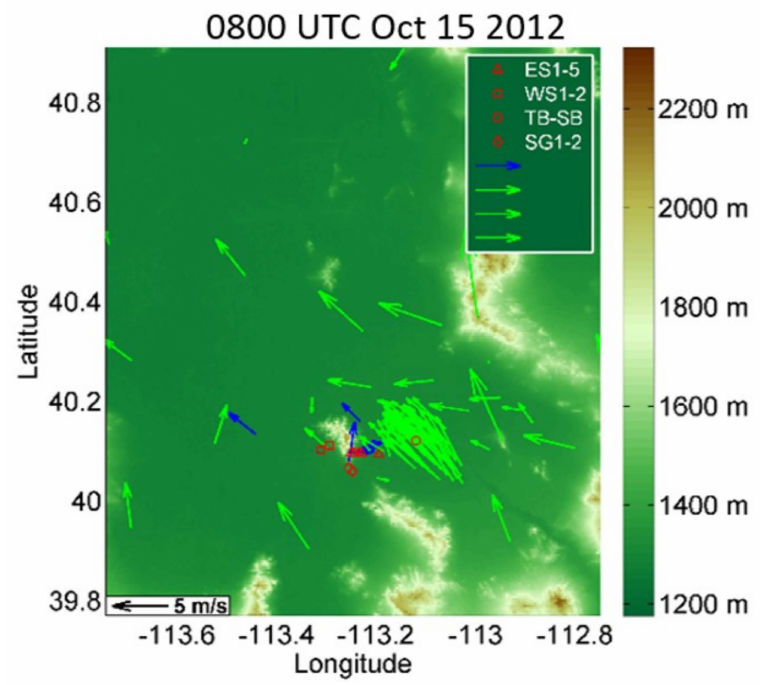
Figure 15. SAMS, mini-SAMS and other special MATERHORN 10 m AGL surface observations capturing flow over the GSL Playa, Granite Peak, and Dugway Valley at 0800 UTC 10-15-2012.